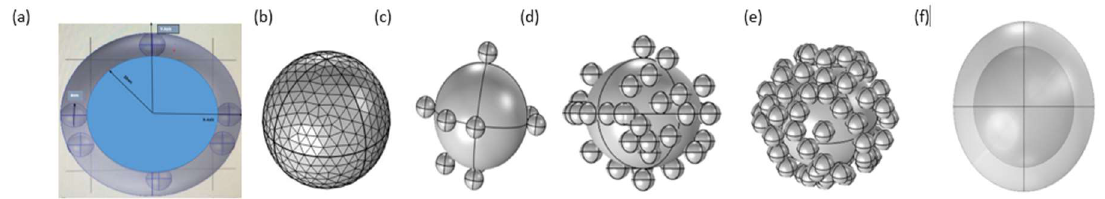
Figure 4. Different shapes used in simulations: ( a ) nano-ellipsoid, ( b ) nanorod and ( c ) nano- sphere.